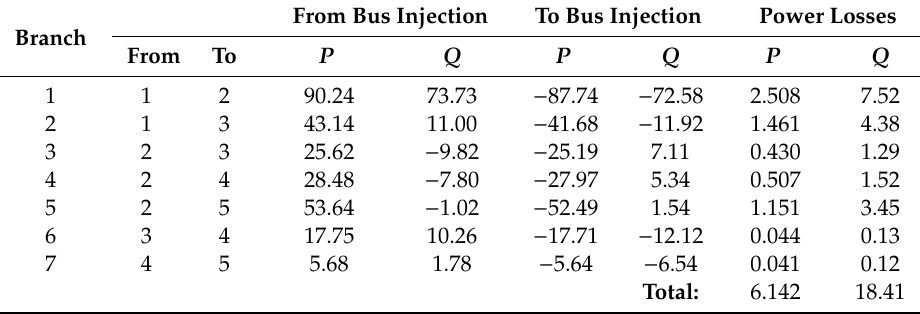
Table A19. Results of the mixed AC / DC PF calculations in Case 5. AC branch